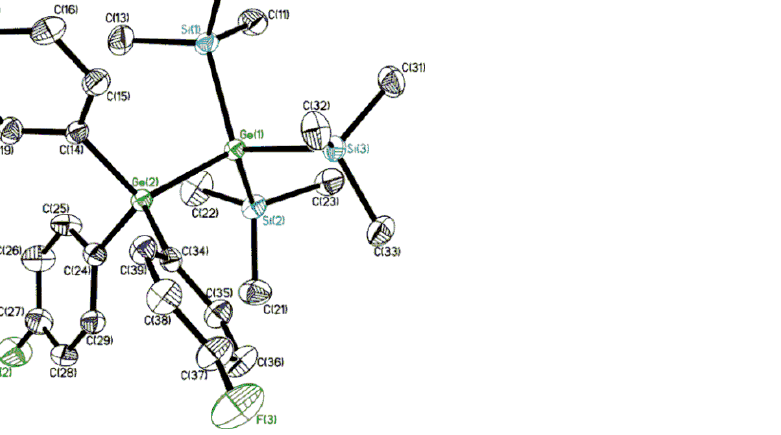
Figure 2. Molecular structure of compound (Me 3 Si) 3 Ge-Ge(C 6 H 4 F- p ) 3 ( 2 ). Only one independent molecule is drawn. Displacement ellipsoids are shown at a 50% probability level. Hydrogen atoms are omitted for clarity. Selected bond lengths (Å ) and bond angles (deg): Ge(1)-Ge(2) 2.4431(3), Ge(1)-Si av 2.3908(5), Ge(2)-C av 1.9625(16); Si-Ge(1)-Si av 109.350(18), Si-Ge(1)-Ge(2) av 109.590(14), C-Ge(2)-C av 107.49(7), C-Ge(2)-Ge(1) av 111.39(5).